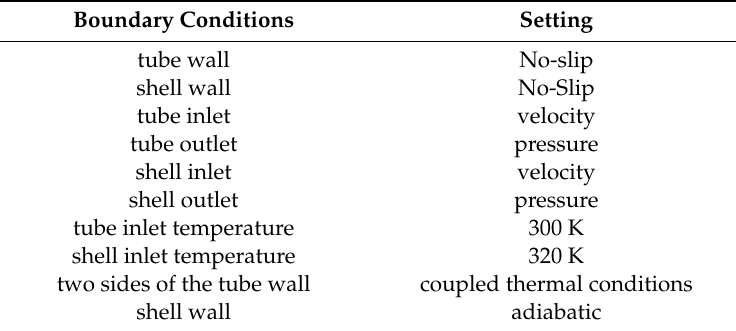
Figure 11. The computational domain. Table 6. Details of the boundary